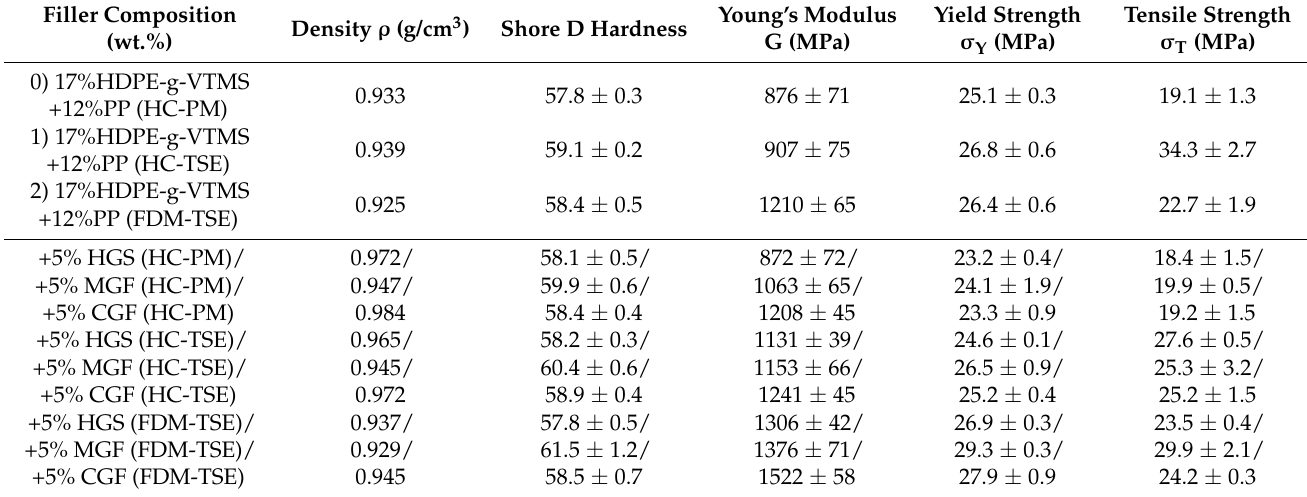
Table 5. The mechanical properties of the ‘UHMWPE+17%HDPE-g-VTMS+12%PP’-based composites. Filler